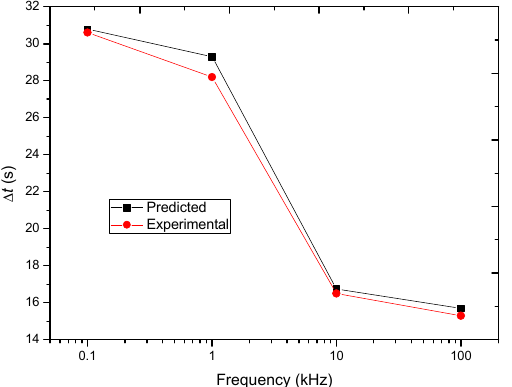
Table 2. Deduced values for the BNNSs under nanosecond pulses.